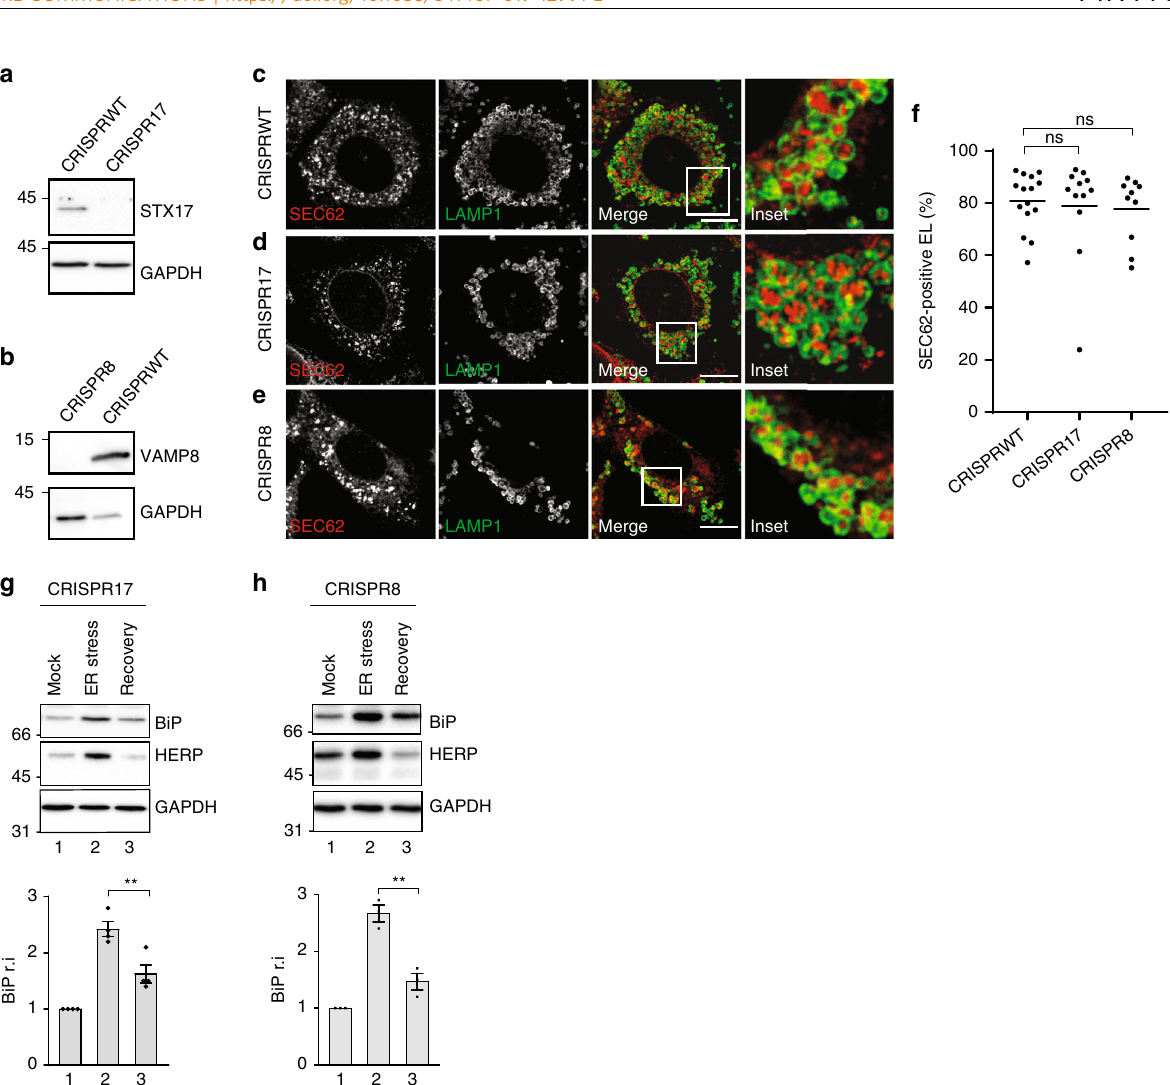
Fig. 3 SNAREs dispensability for delivery of endogenous SEC62-labeled EV within EL. a WB analysis showing the ef fi ciency of STX17 knockout in CRISPR17 MEF (please also refer to ref. 19 ). b Same as a for VAMP8 in CRISPR8 MEF (please also refer to ref. 19 ). c Delivery of endogenous SEC62-labeled EV within LAMP1-positive EL during recovery from CPA-induced ER stress in WT MEF exposed to 50 nM BafA1 for 12 h. d Same as c in MEF lacking STX17. e Same as c in MEF lacking VAMP8. Scale bars: 10 μ m. f Quanti fi cation of EV delivery within EL in c – e ( n = 15, 12, 10 cells, respectively). One-way ANOVA and Dunnett ’ s multiple comparisons test, n.s. P > 0.05. IF panels are representative of three independent experiments. g Same as Fig. 1a in cells lacking STX17, n = 4 independent experiments, mean ± SEM, unpaired, two-tailed t test, ** P = 0.0083. h Same as Fig. 1a in cells lacking VAMP8; n = 3 independent experiments, mean ± SEM, unpaired, two-tailed t test, ** P = 0.0043. Molecular weight markers in WB are in kDa